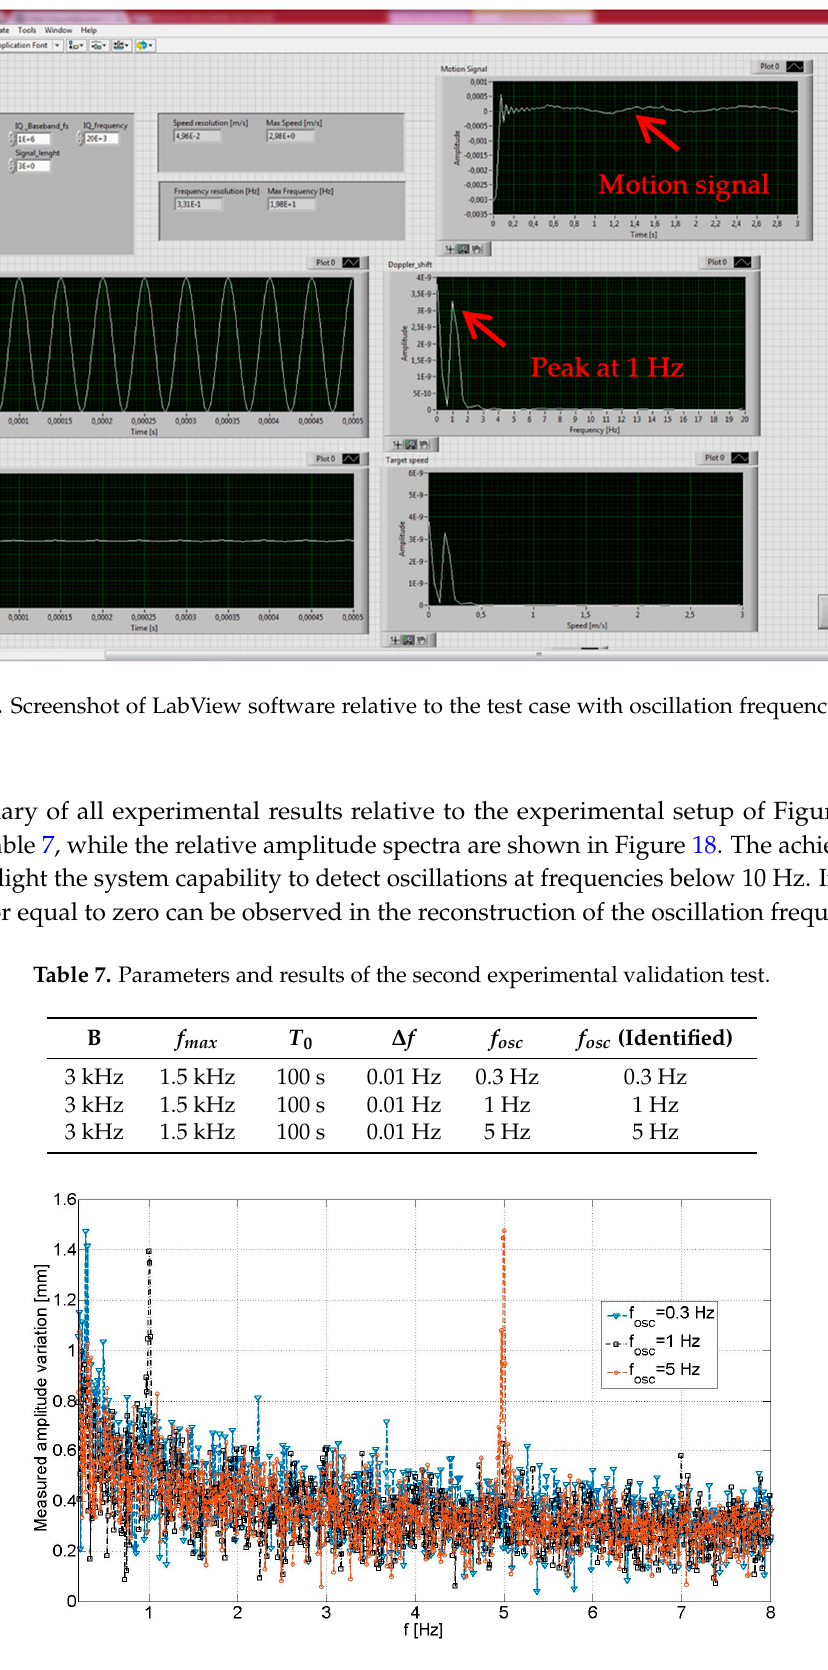
Figure 18. Parameters and results of the experimental validation tests on the second scenario.